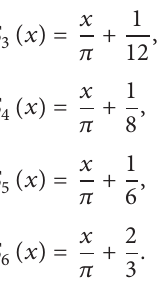
Assume 𝜌 0 𝜌 1 > 0 , 0 < |𝜌 𝑖 | ≤ 1/2 for 𝑖 = 0, 1, . . . , 𝑁 , and, for each 𝑖 , either 𝑆 𝑖 ((0, 1)) ⊆ (0, (1/2)) or 𝑆 𝑖 ((0, 1)) ⊆ (1/2, 1) . 𝑁 Then the IFS {𝑆 𝑖 } 𝑖=1 satisfies